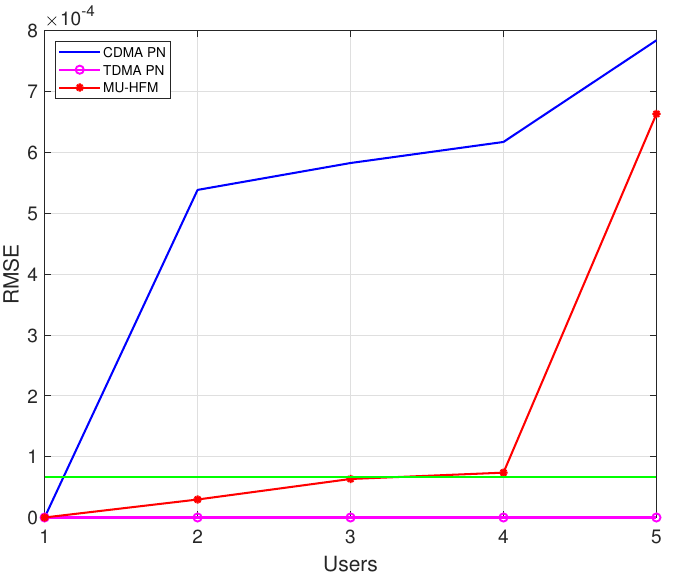
Figure 5. RMSE for Doppler shift estimation based on the number of users for different types of preamble of a 63.75 ms duration for 5000